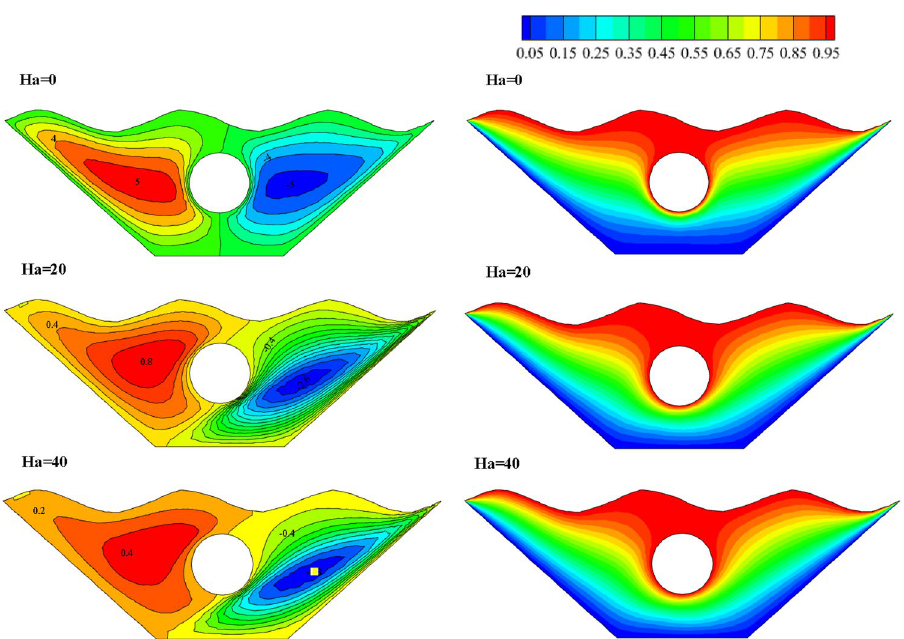
Figure 14. Stream functions and Isotherms for different values of Hartman numbers (Ha) at ℇ = 0.7, Ra = 500, Rd = 0.5 and α =